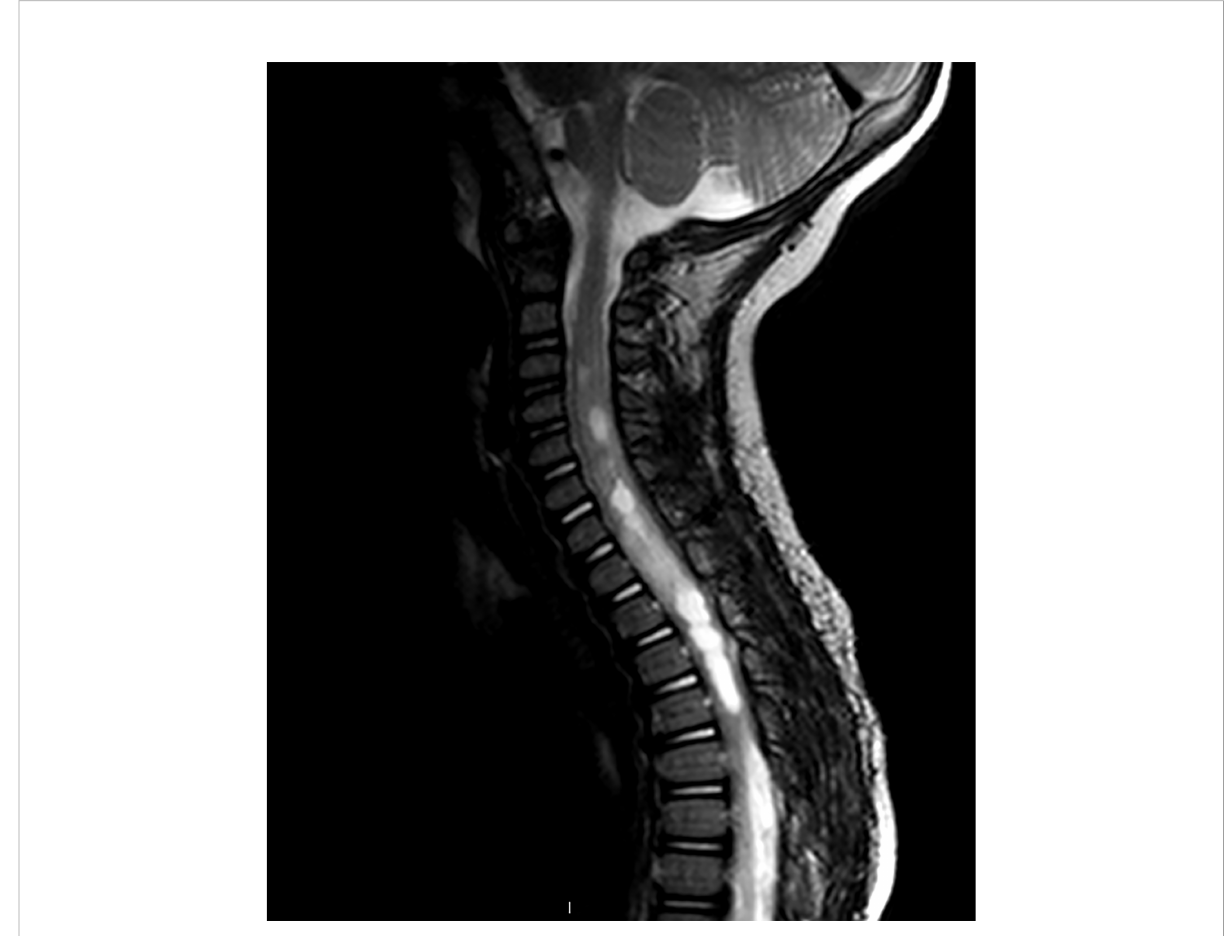
FIGURE 1 Sagittal T2-weighted MRI of pediatric patient with an intramedullary mass extending from C4-T3. Increased T2 signal is seen both cranially and caudally to the tumor. The lesion appears enhancing, although several areas of central non-enhancement consistent with necrosis are visible. Pathology was consistent with a Grade 2